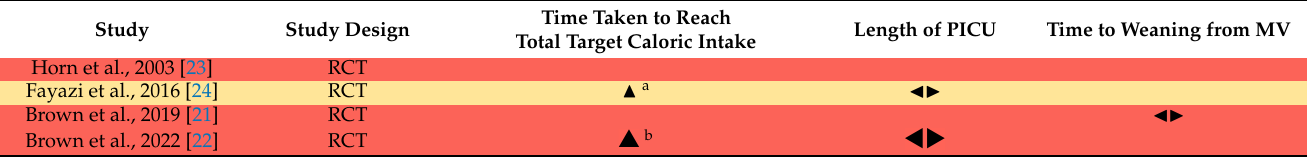
Table 3. Effect-direction plot of the outcomes of our interest.